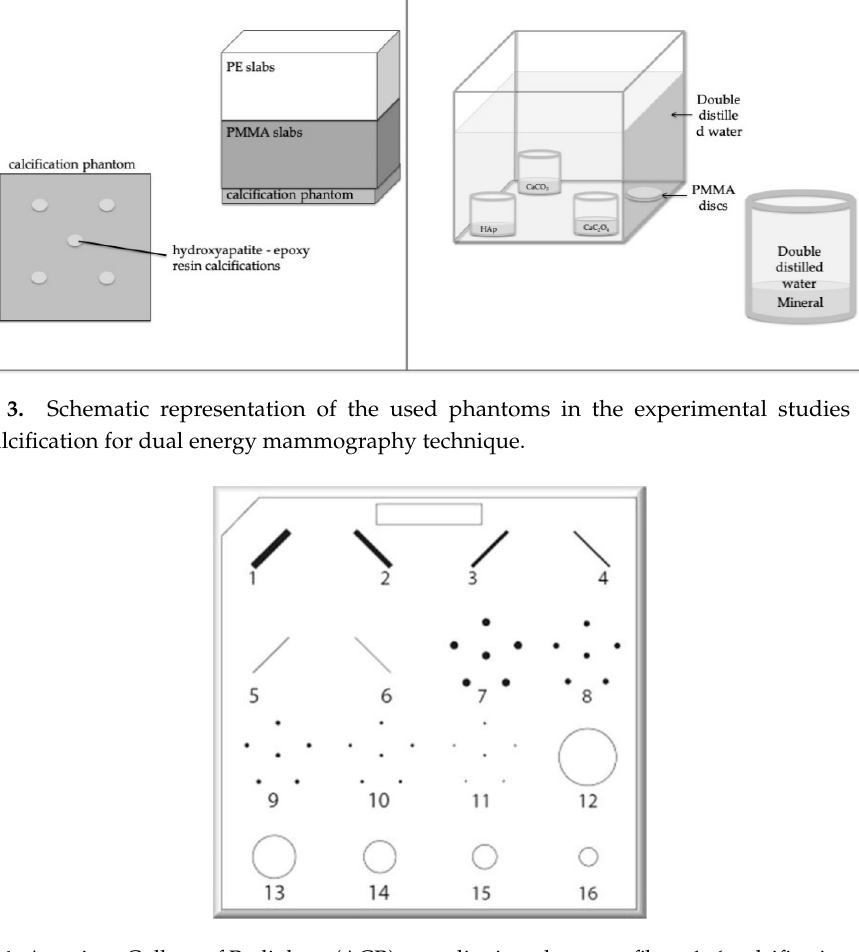
Figure 4. American College of Radiology (ACR) accreditation phantom: fibers 1–6, calcification clusters 7–11, and masses 12–16.